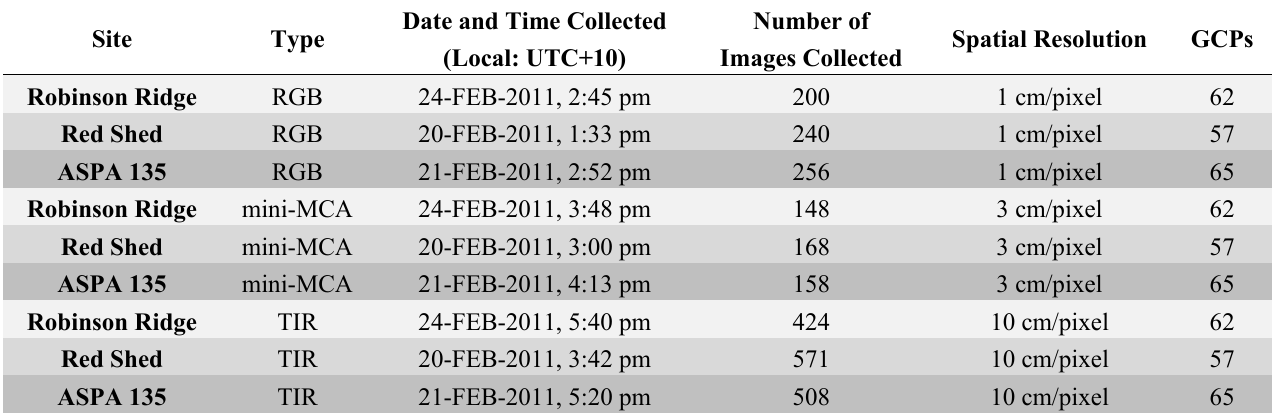
Table 1. Details of acquired image datasets collected at each test